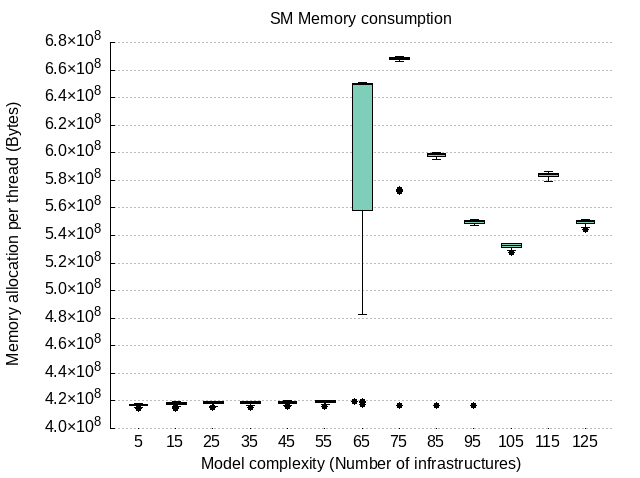
Figure 8. Measurements of thread memory consumption compared to constraints’ model